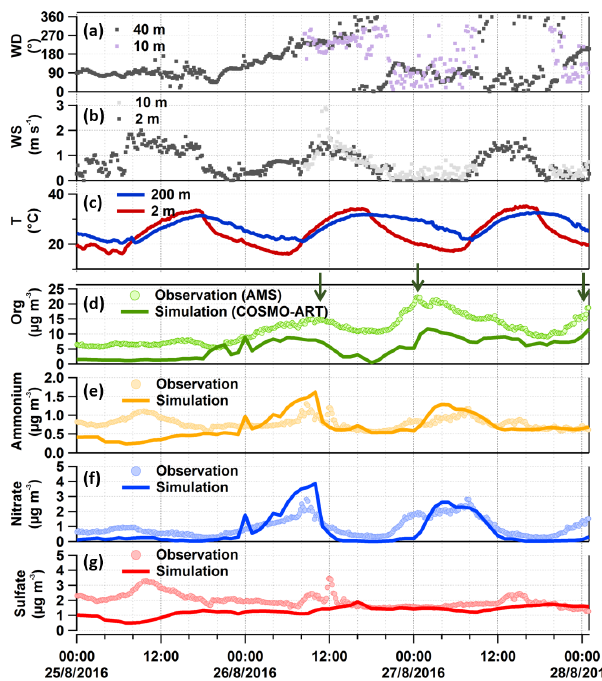
Figure 7. Comparison between observations and model simulations for the organic-rich episode. Panels (a) and (b) are wind conditions measured 10ma.g.l. at our measurement site (purple and light grey dots for wind direction and speed, respectively) and complementary KIT tower data (dark grey dots). Panel (c) shows the temperature data from the KIT tower. Panels (d) to (g) are the particulate organic compounds (with green arrows pointing out the high organic peaks), ammonium, nitrate, and sulfate measured by AMS and simulated by COSMO-ART. The simulation results are at the lowest atmospheric level in the model, namely